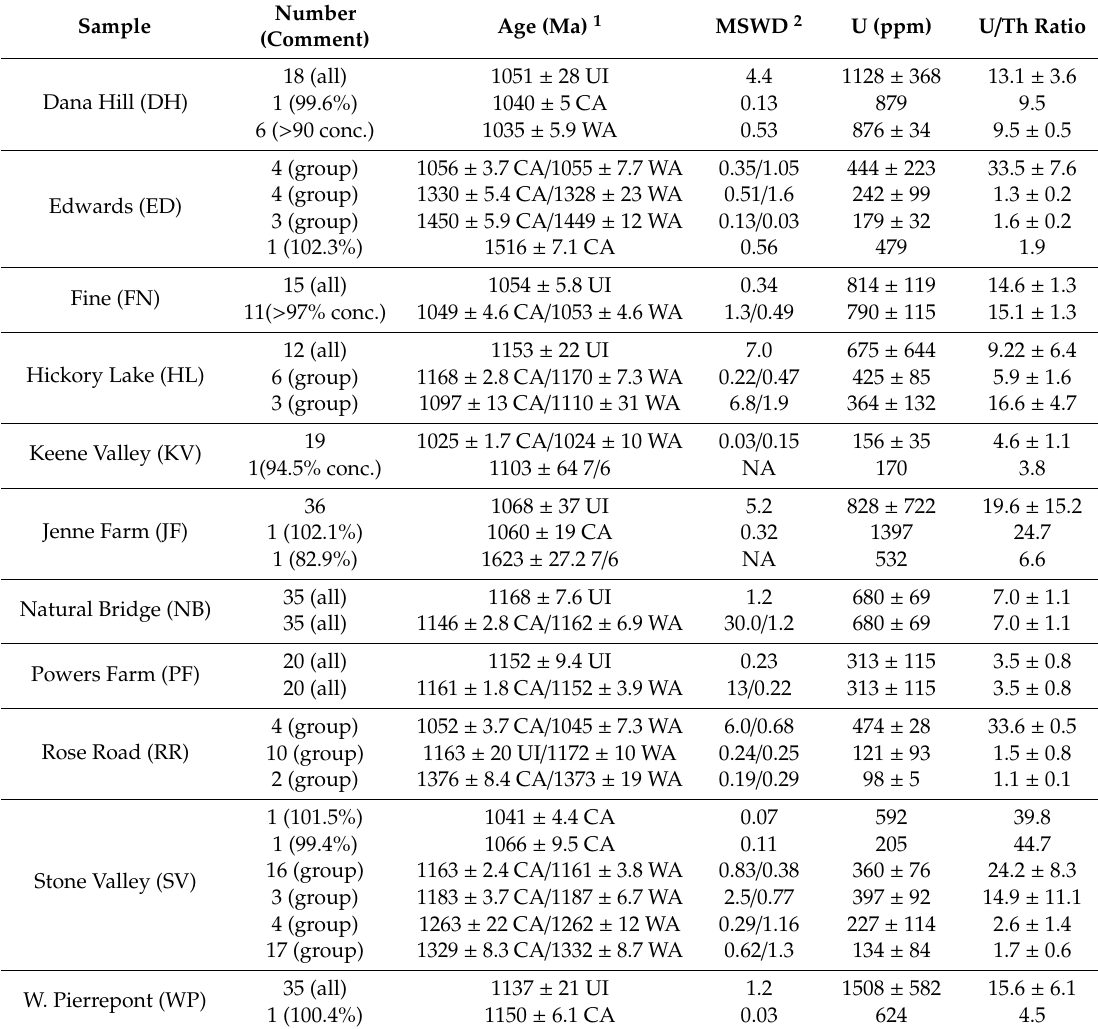
Table 2. U–Pb zircon geochronological results from silicocarbonate